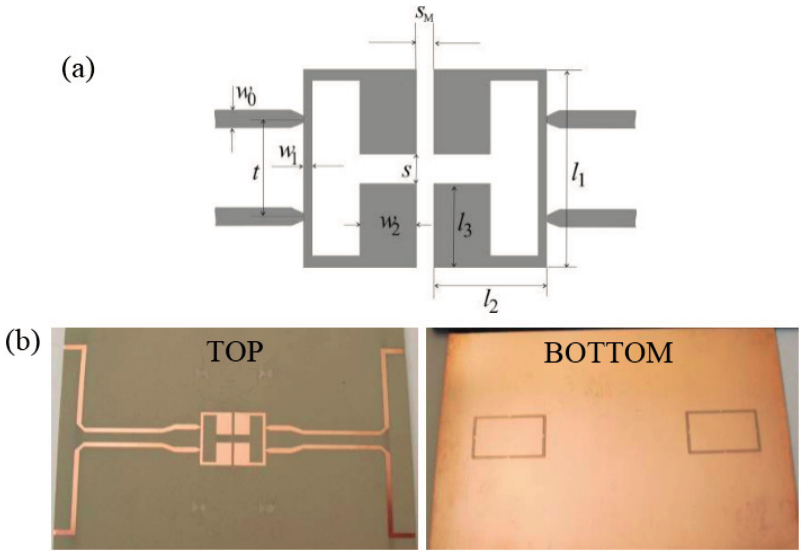
Figure 19. Layout ( a ) and photograph ( b ) of the designed differential bandpass filter with improved common-mode rejection. Dimensions are: for the DS-CSRRs, c = d = 0.2 mm, longitudinal side length = 17.6 mm, and transverse side length = 10.8 mm; for the differential line, W = 1 mm, and S = 2.5 mm; for the differential filter, S M = 0.5 mm, s = 2 mm, w 0 = 1.2 mm, w 1 = 0.7 mm, w 2 = 3.7 mm, l 1 = 12.8 mm, l 2 = 7.5 mm, l 3 = 5.4 mm, and t = 5.5